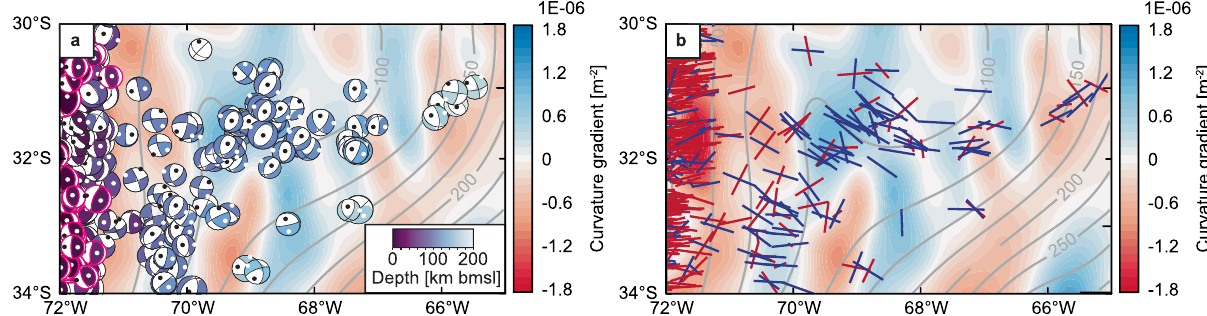
Fig. 5 Slab geometry and slab seismicity in the region of the fl at-slab to steep-dip subduction transition. Curvature gradient of the top of the slab in the transition between fl at and steep-slab subduction (Supplementary Note 2), superposed with a focal mechanism solutions of inter-plate and intra-slab earthquakes 24,25 colour-coded by depth (dots show the orientation of the P- (black) and T-(white) axes); and b P-(red) and T-(blue) axes projected horizontally. Only the sub-horizontal axes (plunge <45°) are shown. The inter-plate events in a are bordered in magenta. The isobath contours of the top of the slab are shown in grey lines. The geometry of the top of the slab was taken from Rodriguez Piceda et al. 93 , based on Hayes et al. 75